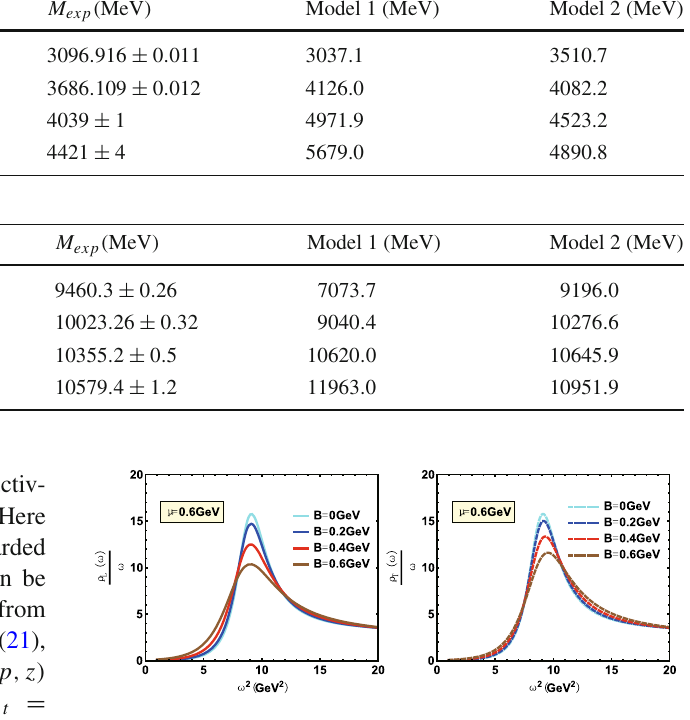
Fig. 1 The spectral function of the J /(cid:2) state with different magnetic field B at T = 0 . 3GeV. The left picture is for magnetic field parallel to polarization and the right one is for magnetic field perpendicular to polarization